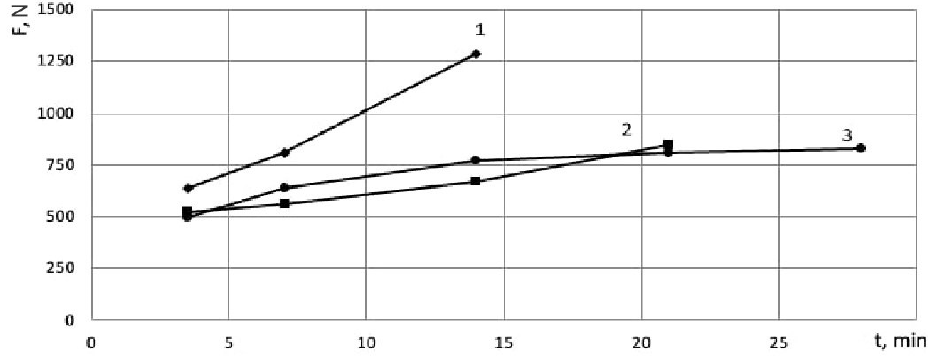
Figure 8. Graph of the cutting forces vs. the cutting speed: 1— V = 50 m/min; 2— V = 35 m/min; 3— V